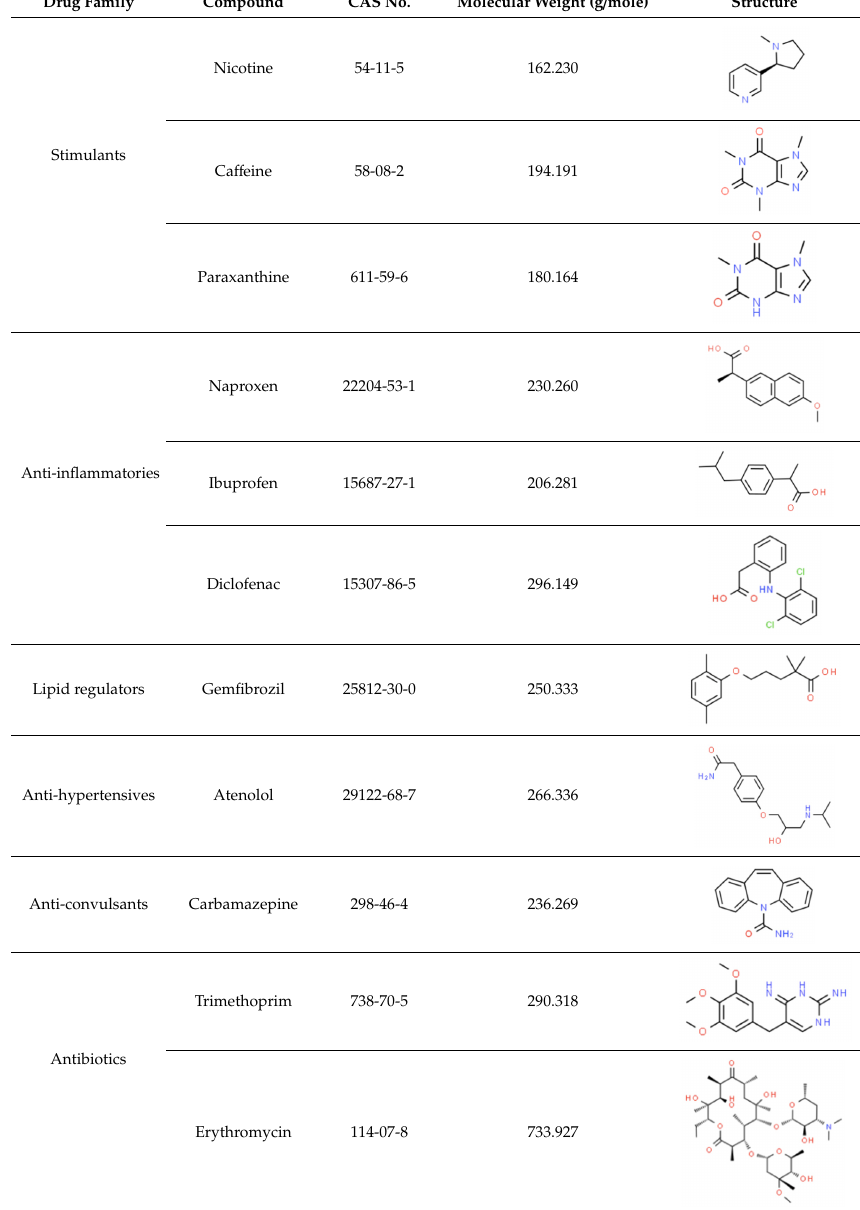
Table 1. Names, identification numbers, molecular weights, and structures of target pharmaceuticals. Drug Family